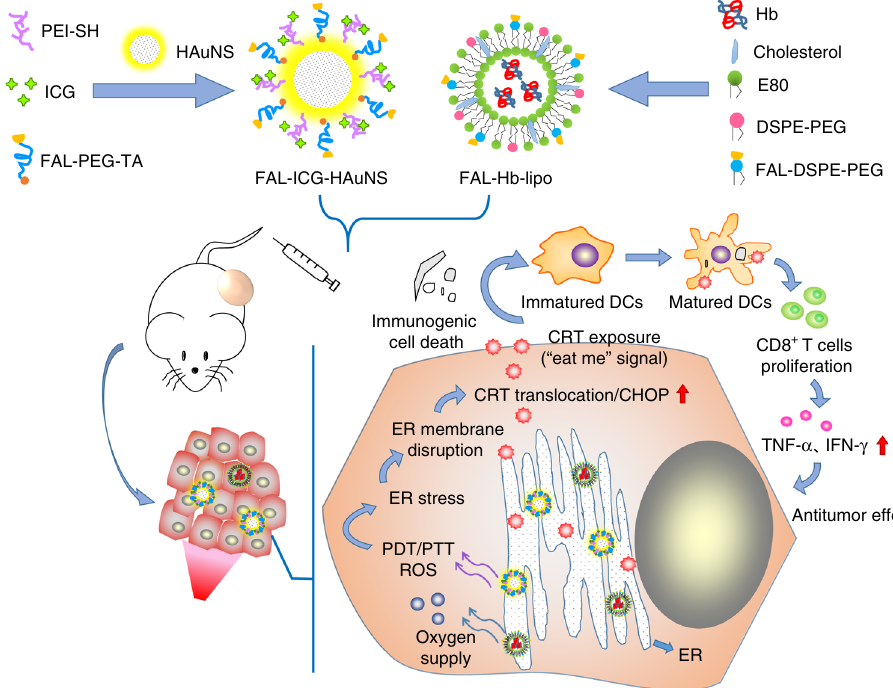
Fig. 10 The antitumor mechanism of FAL-ICG-HAuNS plus FAL-Hb-lipo. Schematic illustration of enhanced immunogenic cancer cell death and anticancer effect induced by endoplasmic reticulum-targeting photothermal/photodynamic